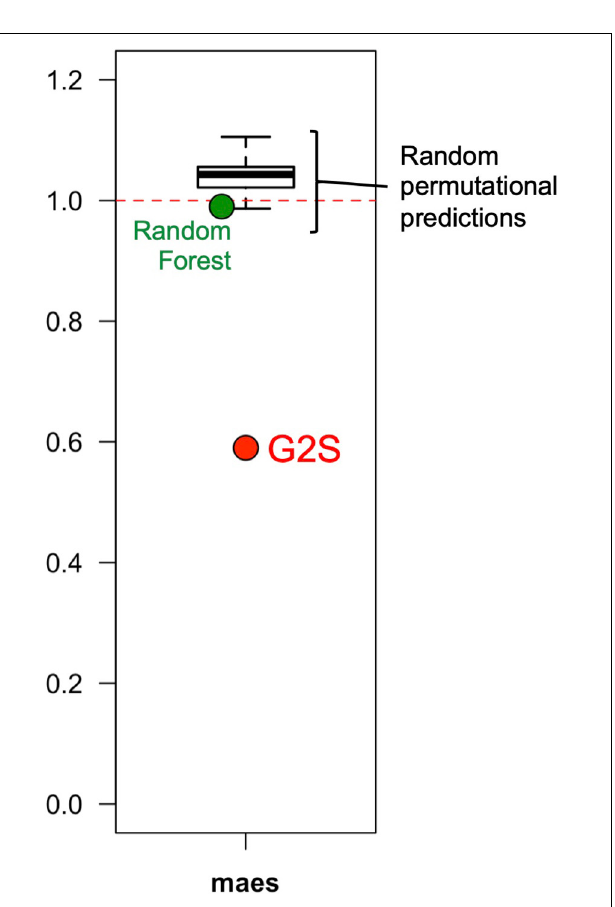
FIGURE 4 | G2S predicts the stool microbiome configuration with better performance than other methods. The mean absolute errors scaled to one standard deviation (maes) between the real data of the samples from the test dataset and the configurations inferred by G2S, Random Forest and a stochastic permutational method (100 predictions), are reported in the dot